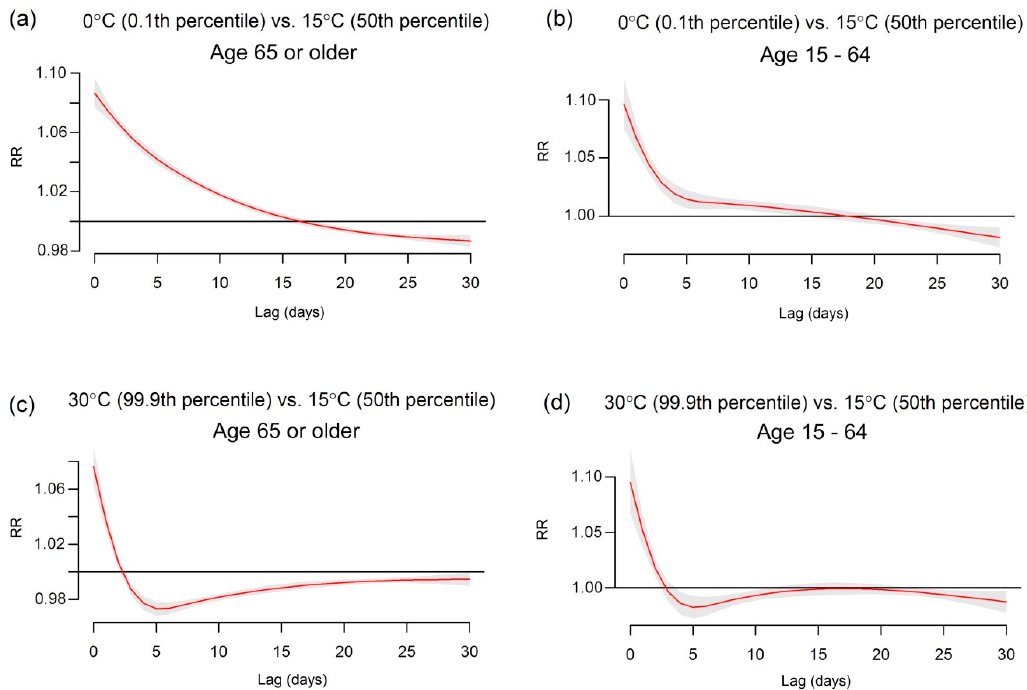
Figure 5. The estimated delayed effects of extreme temperatures on IHD deaths for population aged 65 years or older and age of 15–64 in Japan, 1973–2012. The red lines show the mean association and the grey areas are 95% confidence intervals. The plots show the cold effects on ( a ) aged 65 years or older; ( b ) age of 15–64; and the heat effects on ( c ) aged 65 years or older; ( d ) age of 15–64.